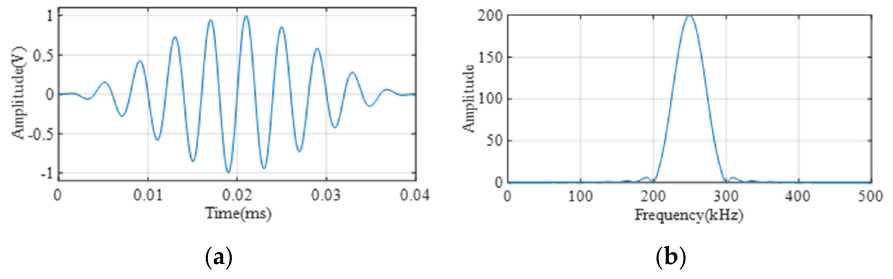
Figure 9. Excitation ultrasonic signal in: ( a ) time domain; ( b ) frequency domain.